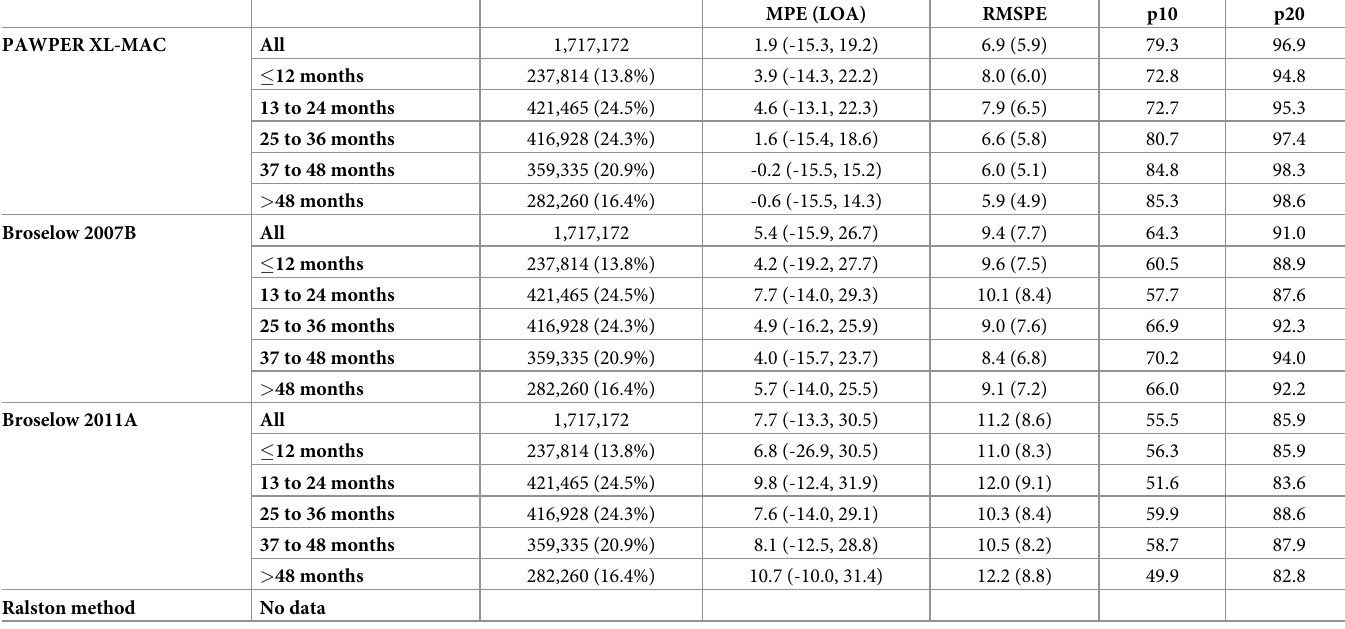
Table 4. Weight estimation performance by subgroups of age.